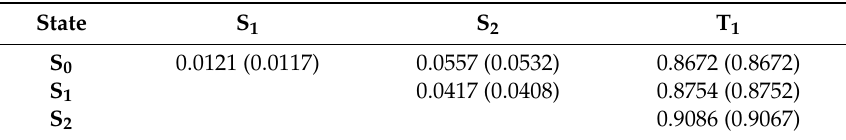
Table 6. Similarity indices d AB calculated at the CASSCF(4,4) / 6-311 ++ G(2d,2p) level for low-lying electronic states of square C 4 H 4 . Values in brackets are π -only contributions to the total index.